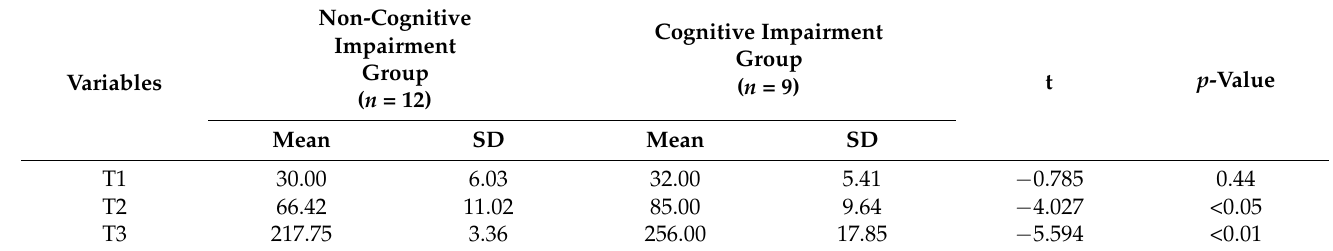
Table 5. Differences in time to completion of different tasks between users in the non-cognitively impaired and cognitively impaired